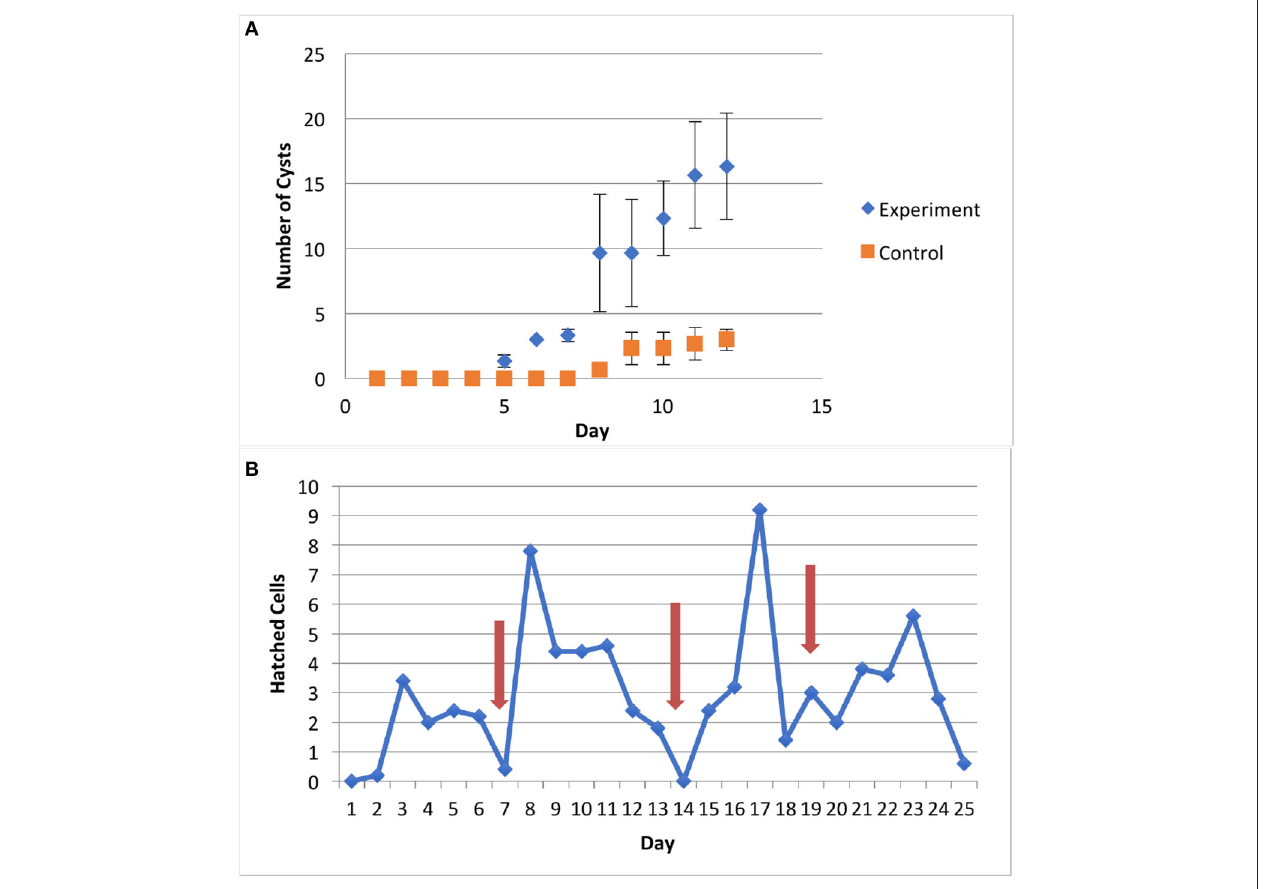
FIGURE 3 | (A) Results of encystment experiment. Shortened photoperiod (12:12–9.5:14.5) and decrease in temperature (20 ◦ -10 ◦ C) over 12 days induced formation of more cysts, compared to controls (12:12, 20 ◦ C); error bars are one standard deviation ( n = 3). (B) Excystment was stimulated by rinsing cysts with fresh medium